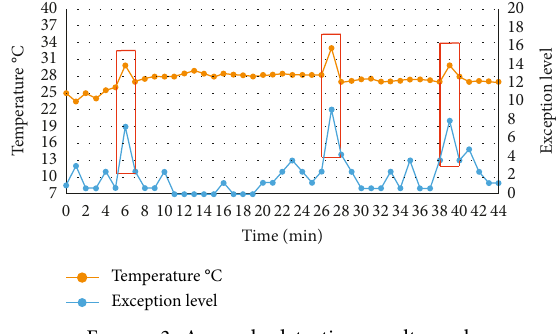
Figure 3: Anomaly detection result